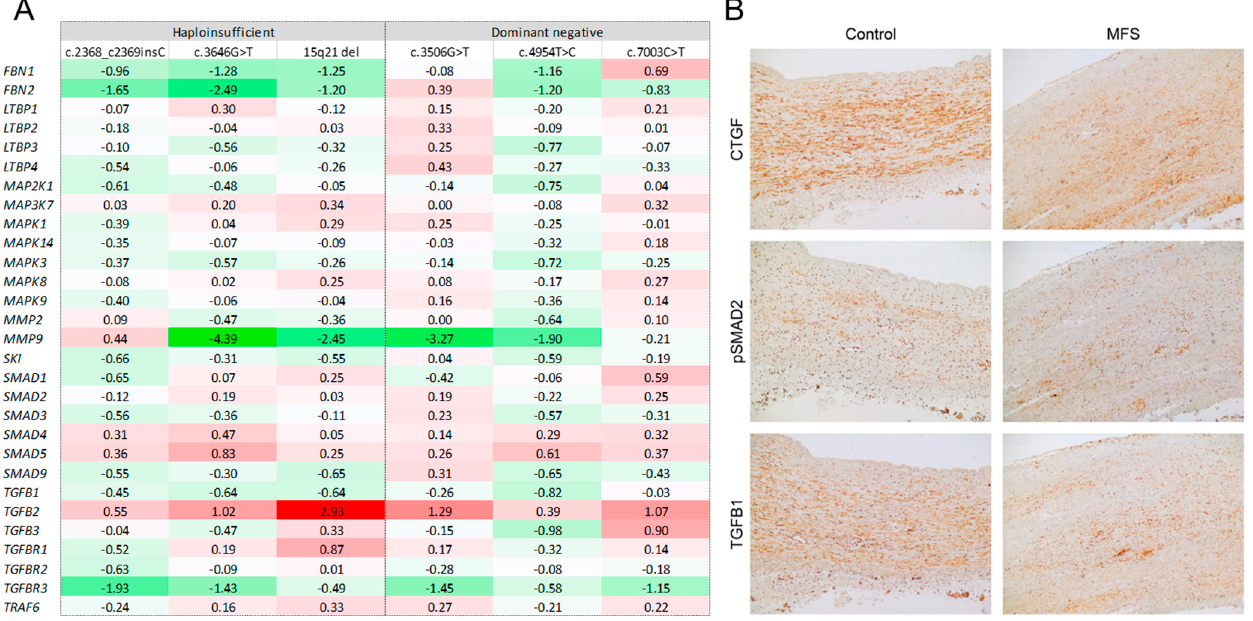
Figure 2. Targeted assessment of the canonical TGF- β signaling pathway. ( A ) Heatmap depicting TGF- β pathway deregulation scores (fold changes) in individual MFS patients. ( B ) Representative images of immunohistochemical analysis of TGF- β family proteins in aortic tissue of control and MFS patient. Labeling intensity and distribution of these markers were comparable between both groups.